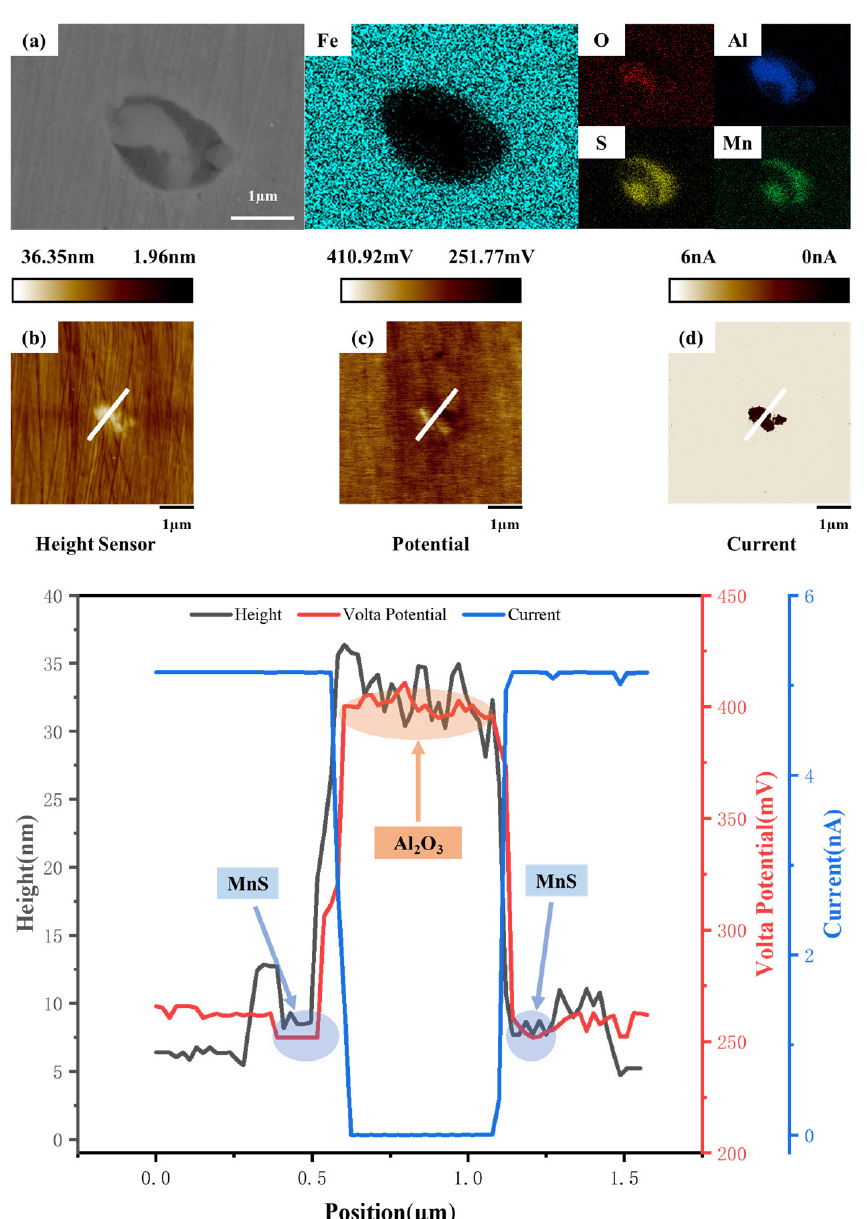
Figure 3. FE-SEM-EDS and micro-electrochemical measurements of Al 2 O 3 -MnS inclusions: ( a ) FE- SEM-EDS image; ( b ) AFM topography; ( c ) Volta potential; ( d )